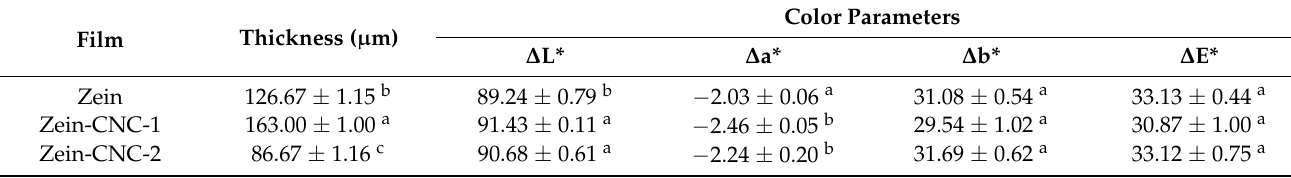
Table 1. The thickness and color parameters of Zein-based films with different adding amounts